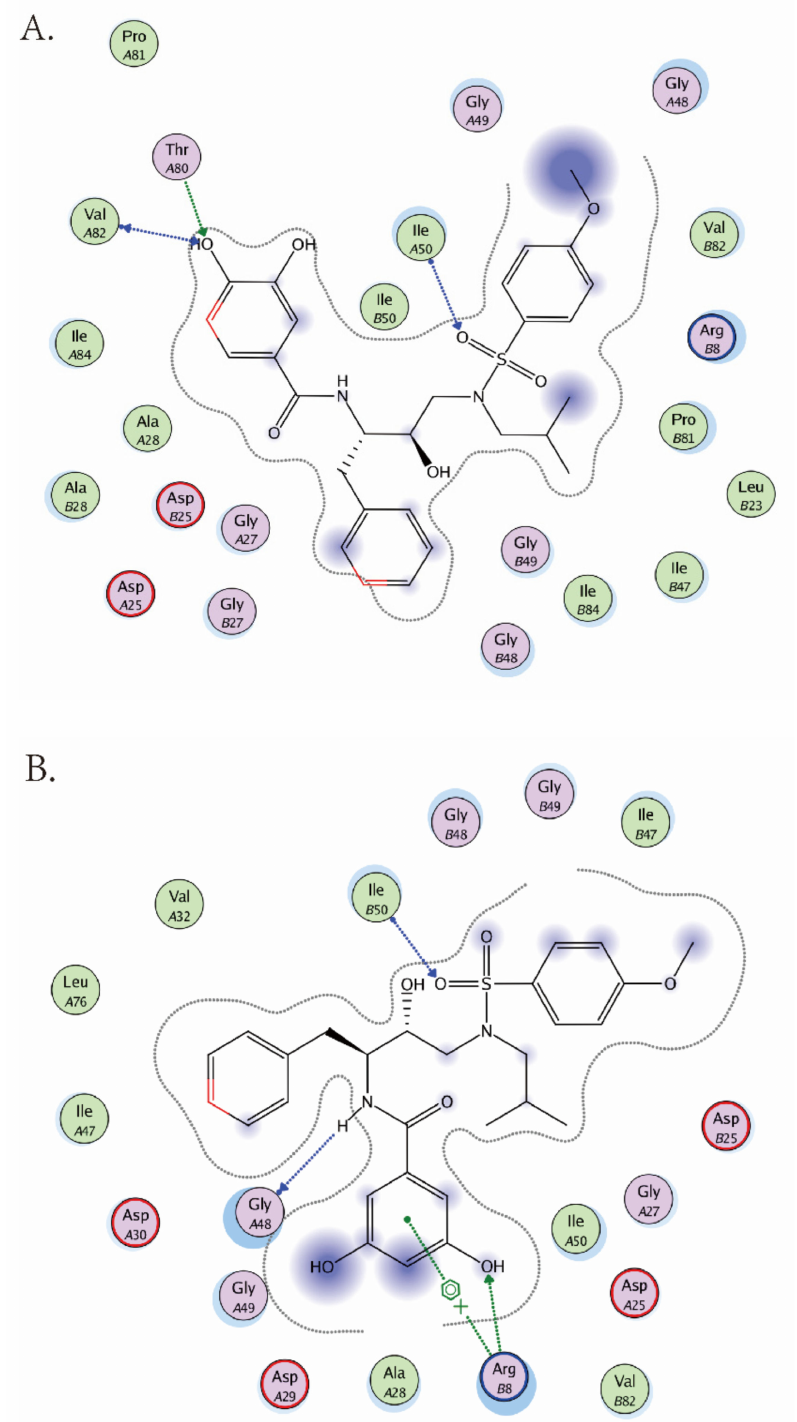
Figure 5. Molecular modeling of inhibitors 15d and 15f . ( A ) Ligplot interaction of 15d . ( B ) Ligplot interaction of 15f . Ligand exposure is represented as purple spheres, hydrogen bonding is depicted as blue or green arrows, and π – π interactions are depicted as green